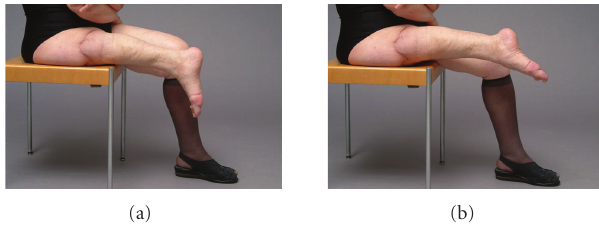
Figure 4: Photographs 6 months postoperatively showing an unrestricted dorsalextension and plantarflexion of the